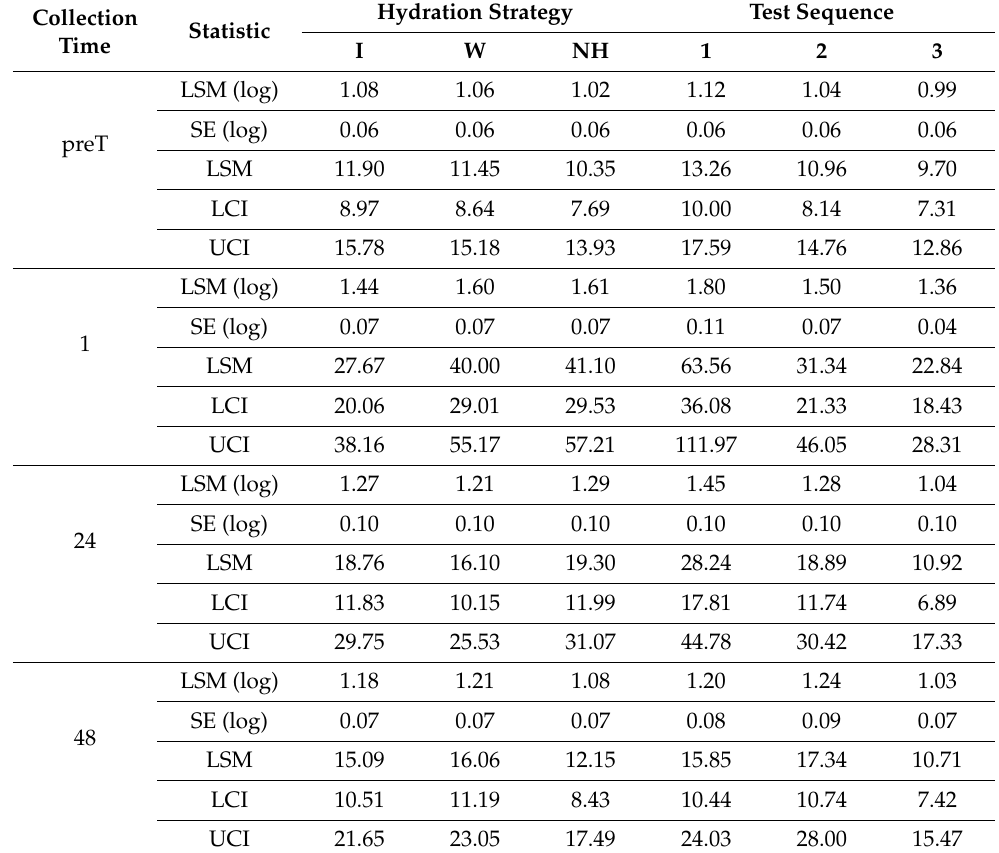
Table 9. Results for myoglobin [ng · mL − 1 ] measured before the test (preT) and 1, 24, and 48 h after the test performed for different hydration strategies in three consecutive tests: marginal means (LSM); standard errors (SE) for values after logarithmic transformation (log); and marginal means and upper (UCI) and lower (LCI) confidence intervals restored to original